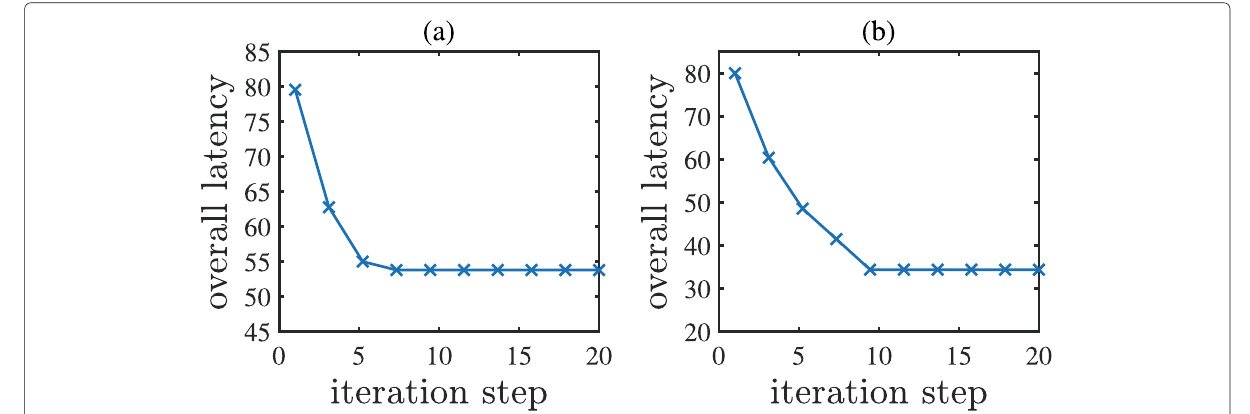
Fig. 11 Algorithm convergence: (a) the result of Example 1, (b) the result of Example